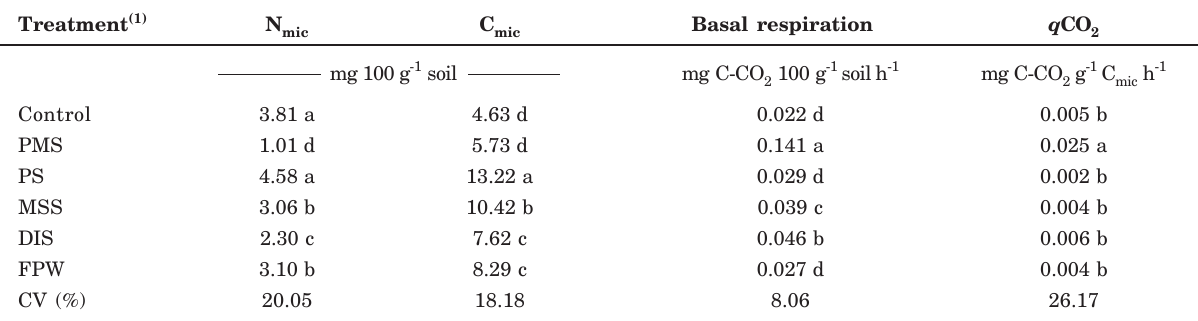
(1) Control: soil without organic waste; PMS: pulp mill sludge, PS: Petrochemical sludge, MSS: municipal sewage sludge, DIS: dairy industry sewage sludge, FPW: waste from fruit pulp industry; C N : microbial biomass nitrogen; CV: coefficient of variation. Means followed by the same letters do not differ by Scott-Knott test mic (p <